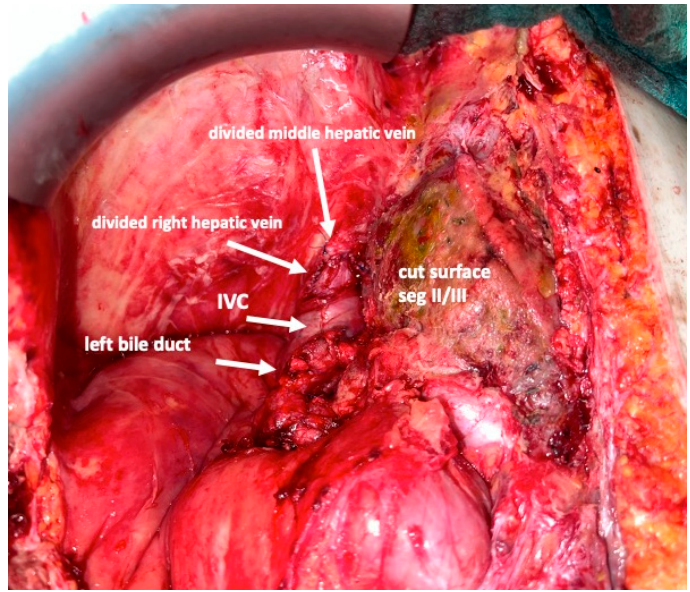
Figure 9. After resection is completed, only a relatively small wound surface remains and the left liver lobe is often already adherent to the surrounding structures, avoiding kinking of the left hepatic vein. If that is not the case, it is recommended to stabilize the left liver lobe by stitching Teres’ ligament to the median abdominal wall.